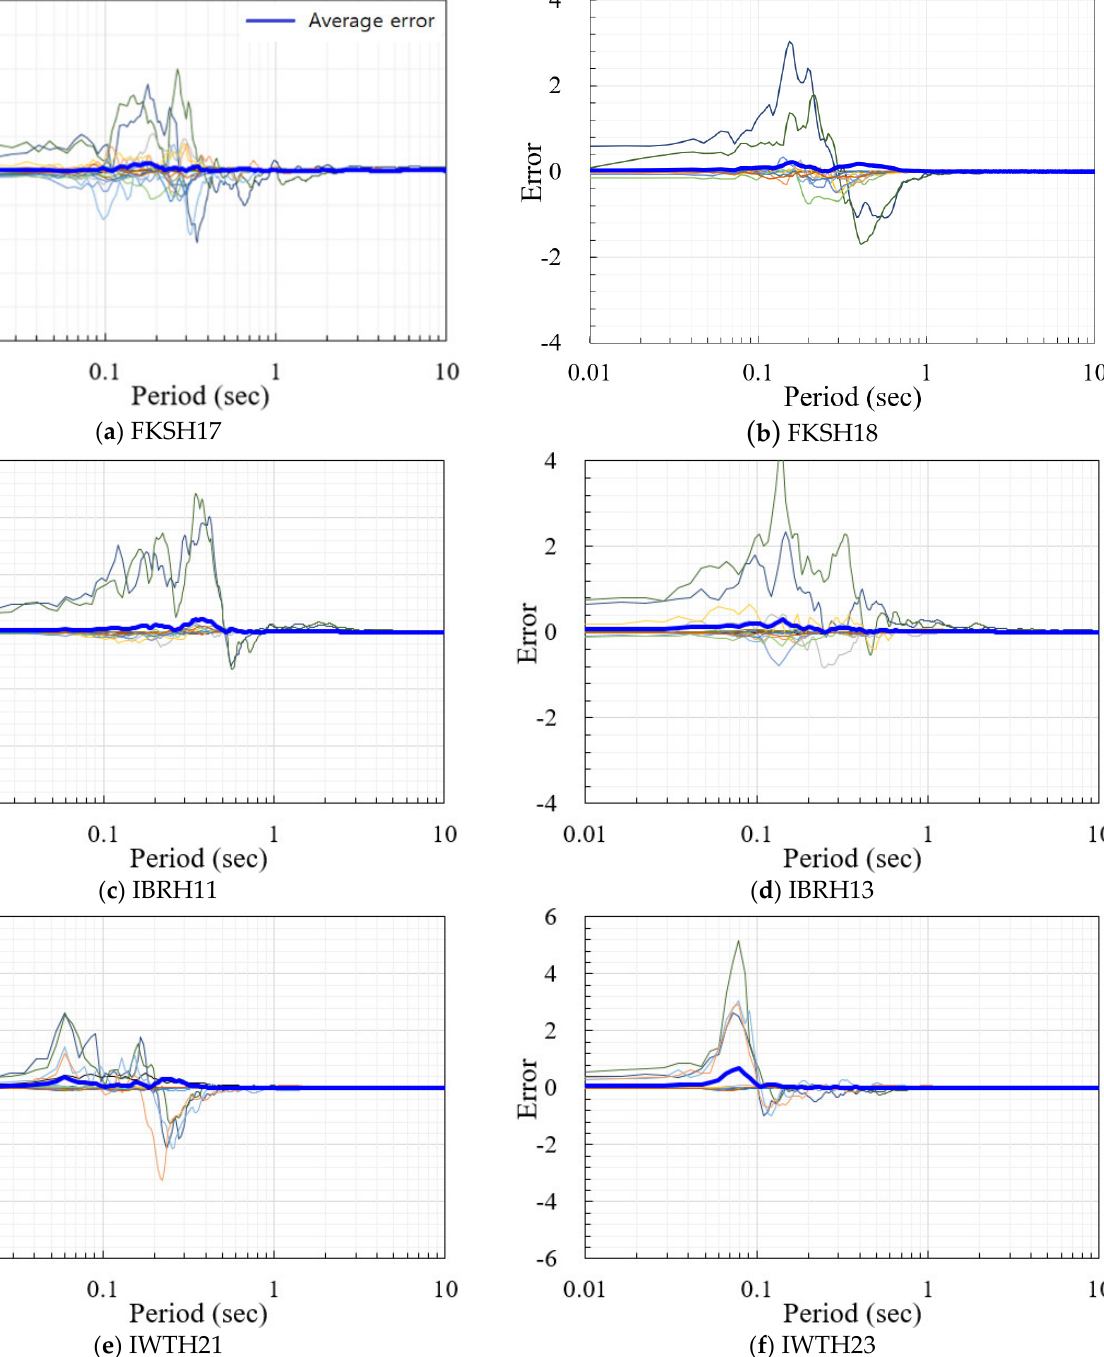
Figure 13. Errors in the ground motions by the MLP model.